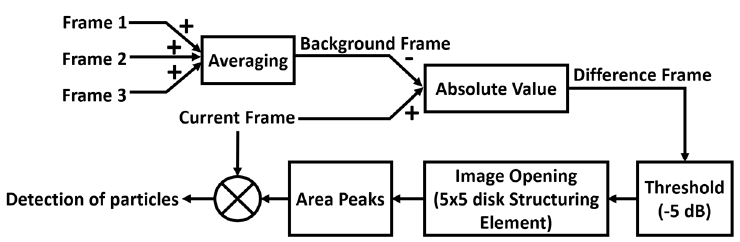
Figure 10. Block diagram to illustrate the particle detecting algorithm.